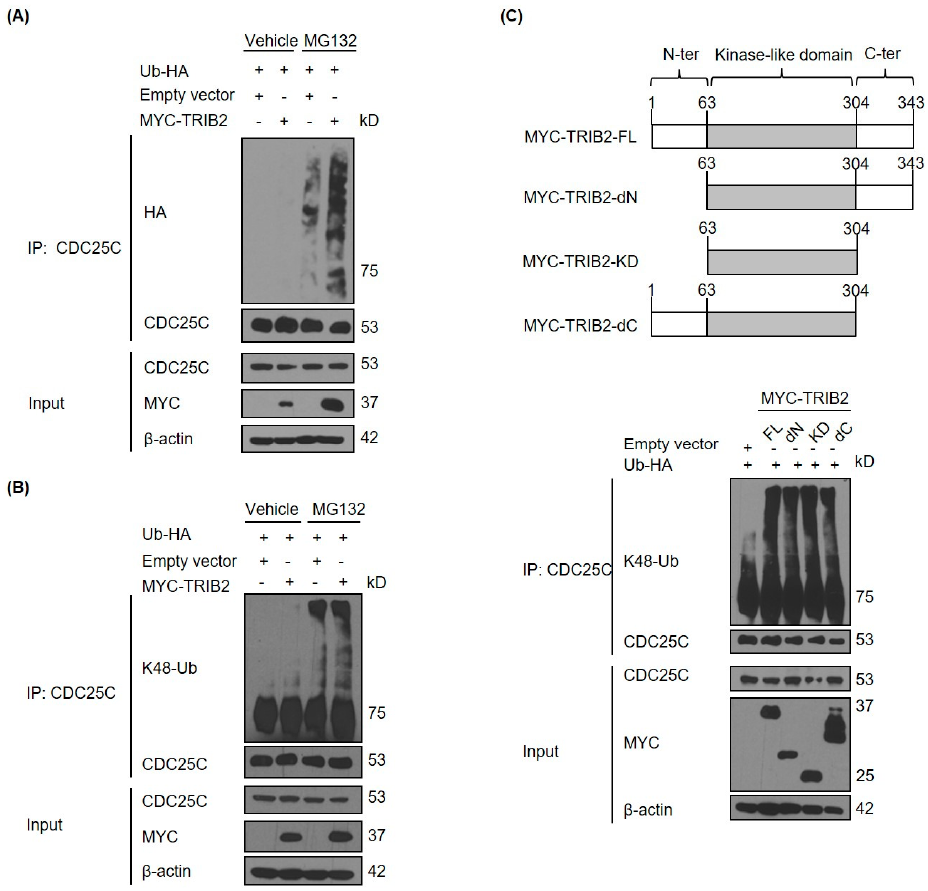
Figure 3. TRIB2 promotes K48-linked polyubiquitination of CDC25C. ( A ) Effect of overexpression of MYC-tagged TRIB2 on ubiquitination of endogenous CDC25C in HeLa cells. Effect of overexpression of ( B ) MYC-tagged TRIB2 wild type and ( C ) different mutants on K48-linked ubiquitination of endogenous CDC25C in HeLa cells. FL, full length; dN, N-terminal deleted; KD, only kinase domain expressed; dC, C-terminal deleted. For ( A , C ), all samples were treated with 10 µM of MG132 for 7 h prior cell lysis. Ub-HA, HA-tagged ubiquitin.